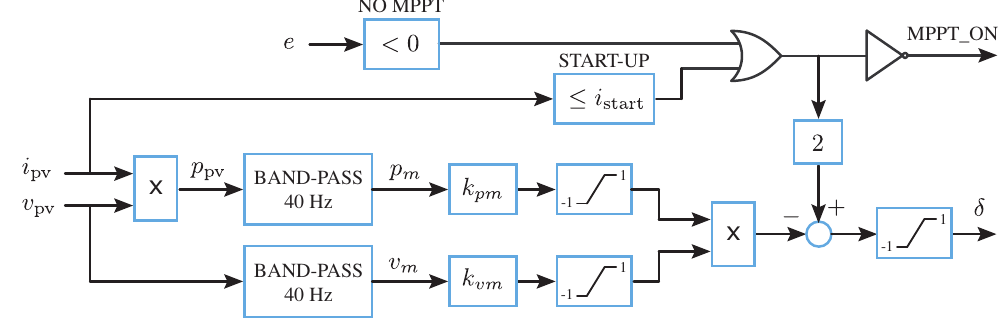
Figure 9. Detection of the operating point position relative to the MPP using the parameter δ .